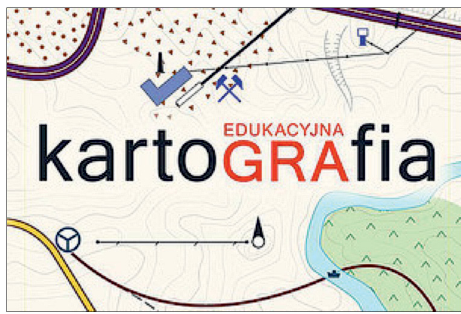
Fig. 3. Educational game KartoGRAfia